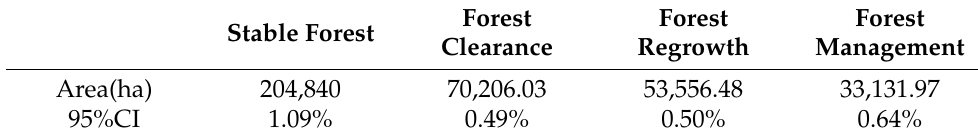
Table 2. Stratified estimators of area ± CI% of total map area from 1995 to